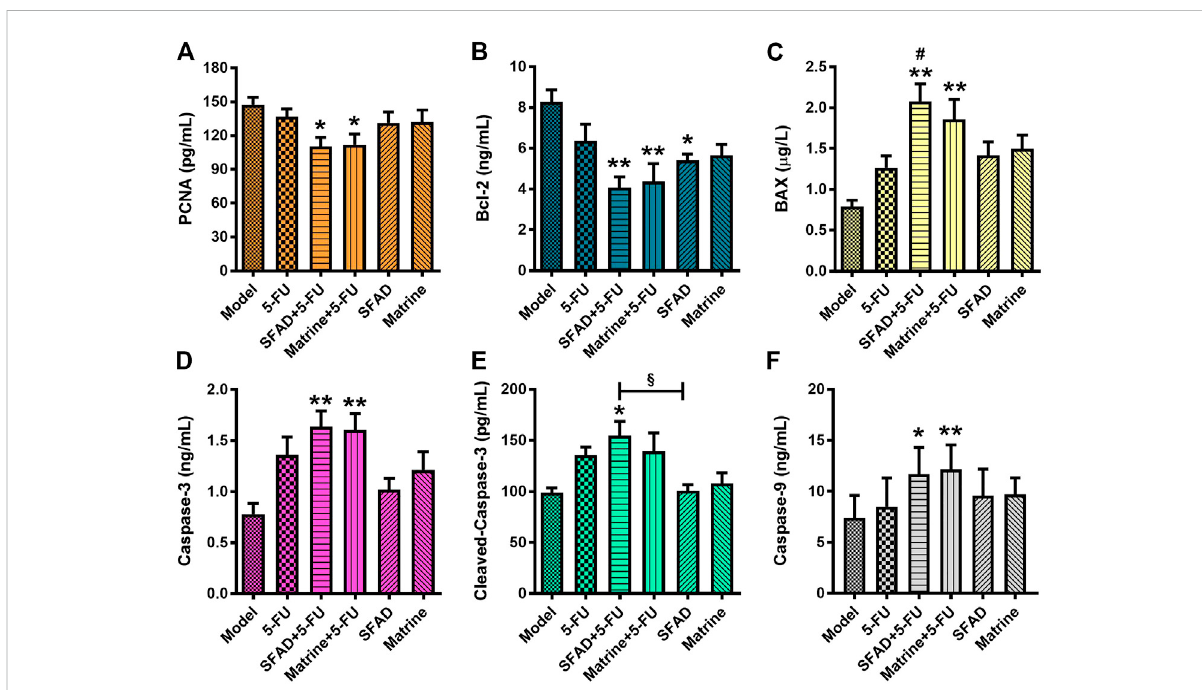
FIGURE 7 Effects of SFA/matrine+5-FU on serum proliferation/apoptosis-related factors in BGC-823-transplanted nude mice. (A) PCNA protein content inserum(pg/ml). (B) Bcl-2proteincontentinserum(ng/ml). (C) BAXproteincontentinserum( μ g/L). (D) Caspase-3proteincontentinserum(ng/ml). (E) Cleaved Caspase-3 protein content in serum (pg/ml). (F) Caspase-9 protein content in serum (ng/ml). Data are presented as the mean ± SD of 7 – 8nudemice. * p < 0.05, ** p < 0.01 vs.themodelgroup; # p < 0.05 vs.the5-FUgroup; § p < 0.05 fortheSFAD+5-FU vs. SFADgroups (one-way